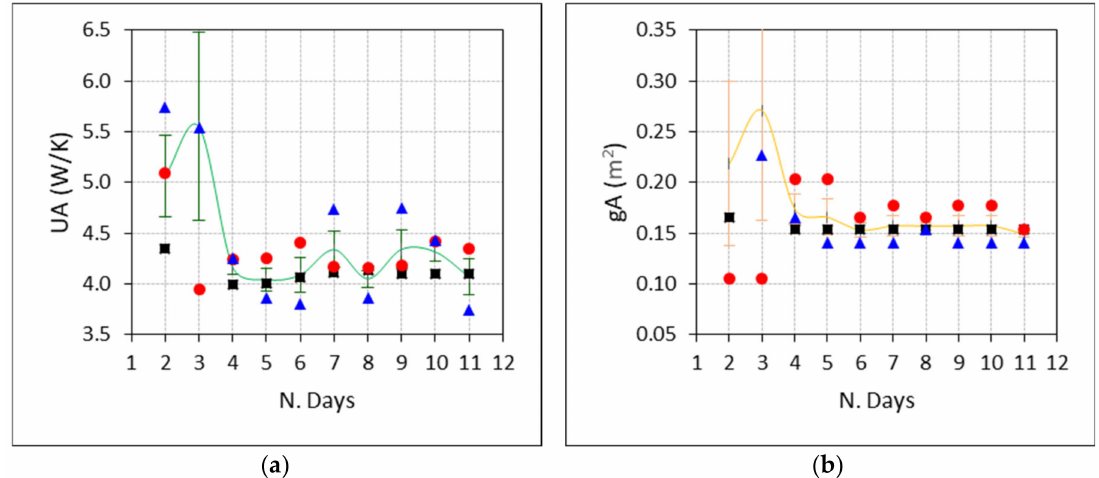
Figure 8. Whole building. Analysis of model performance for di ff erent length of test period. Series a in black, series b in red and series c in blue. The continuous lines represent the average values from the results of the three data series a, b and c. ( a ) UA value. ( b ) gA